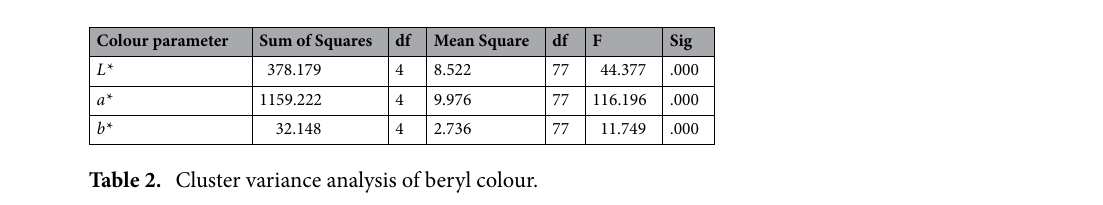
Figure 3. The colour analysis of beryl. ( a ) A negative correlation between the colour coordinate a * and its chroma C* . ( b ) Chromaticity coordinate − b * is highly negatively correlated with hue h °, and the colour coordinate - b* is high negative correlated with chroma C * ( c ) Chromaticity coordinate + b * is highly positively correlated with chromaticity C* and highly negatively correlated with hue h °.